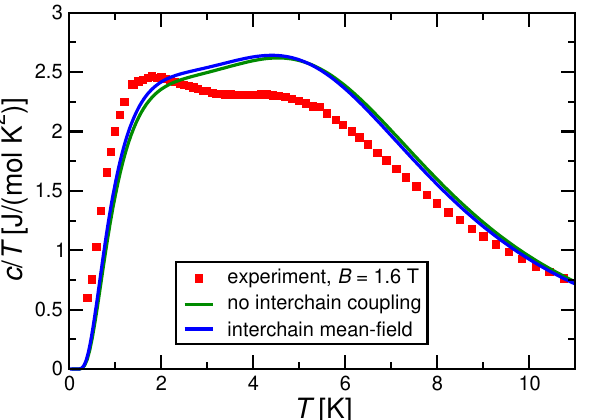
Figure 12. Magnetic specific heat per spin divided by temperature c / T for J = 2.8 K, D = 0.36 K in a magnetic field h = 0.8 J in comparison with the experimental results for B = 1.6 T. As in Figure 11, theoretical results are obtained by ED with N = 10 both for decoupled chains ( J ⊥ = 0) and with a self-consistent mean-field treatment for J ⊥ = 0.072